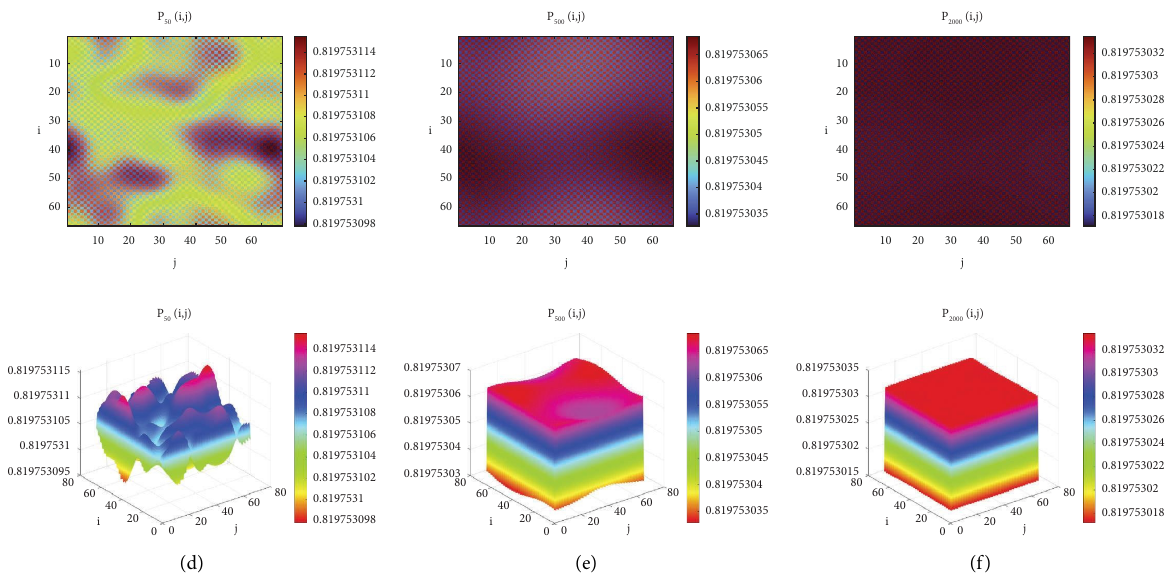
Figure 26: R � 2 ,k � 1, c � 0 . 8, σ ∗ � 0 . 278655, σ � σ ∗ , ( d Figure 9(b), which is consistent with the case of Corollary 3(9), a Neimark-Sacker-Flip-Flip bifurcation occurs, the number of parasites and hosts in two-dimensional space is very complex and can be regarded as a chaotic phenomenon.